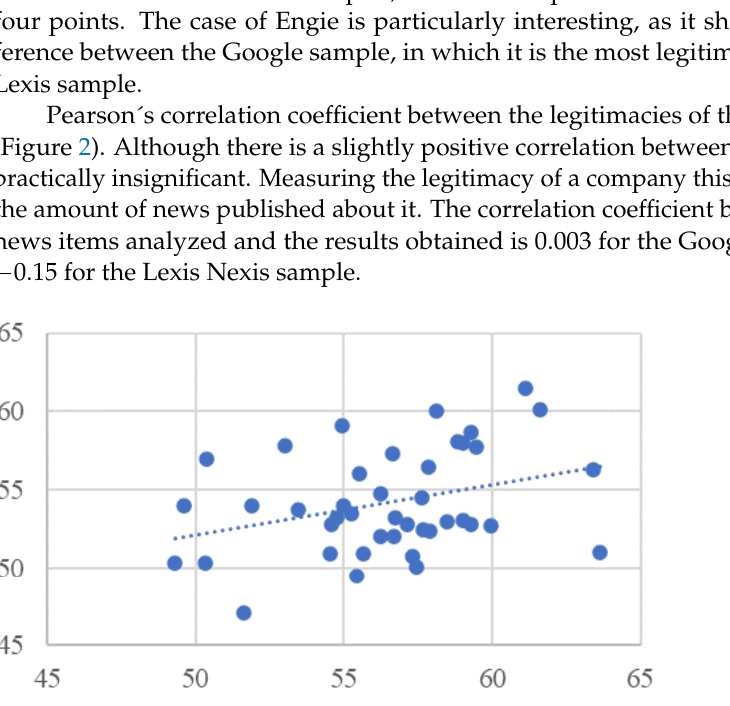
Figure 2. Correlation between legitimacy measured in Google News and Lexis Nexis.